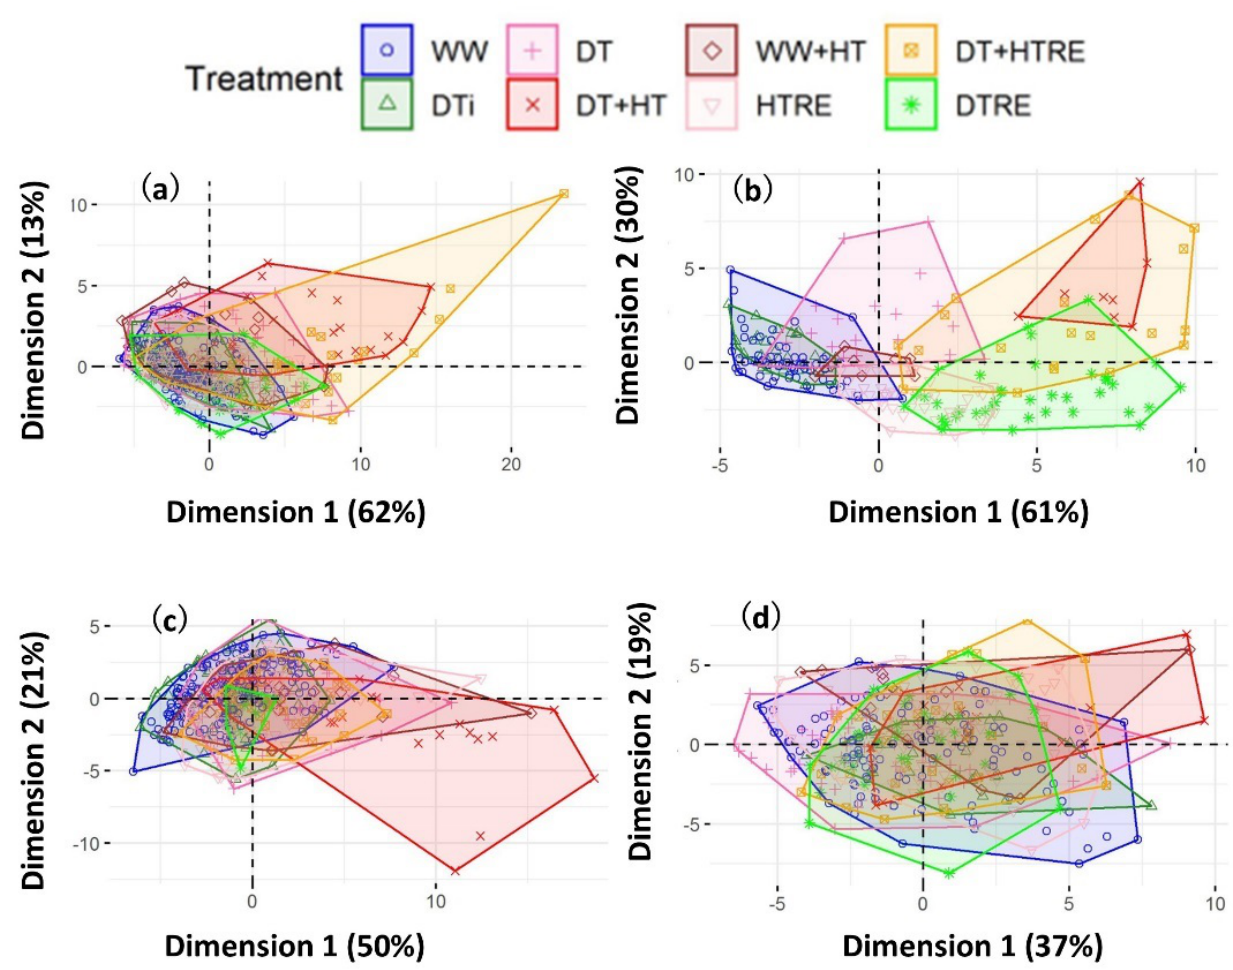
Figure 3. Treatment distributions on the first and second dimensions of the principal component analysis of chlorophyll fluorescence OJIP kinetic parameters in wheat ( a ), sorghum ( b ), F. chinensis ( c ) and R. sinica ( d ). WW: Well-watered; DTi: drought initiation (Day 1—the day before the start of severe drought); DT: drought (the start of targeted drought stress to the start of the heat treatment); WW + HT: well-watered plants subject to heat; DT + HT: DT plants subject to heat; DT + HTRE: heat removed from DT plants; ( d ) HTRE: WW plants removed from heat; DTRE: re-watering of DT plants. Table 1. Definitions and explanations of selected chlorophyll fluorescence OJIP parameters in this study. The parameters are derived from the literatures [19,26,39].